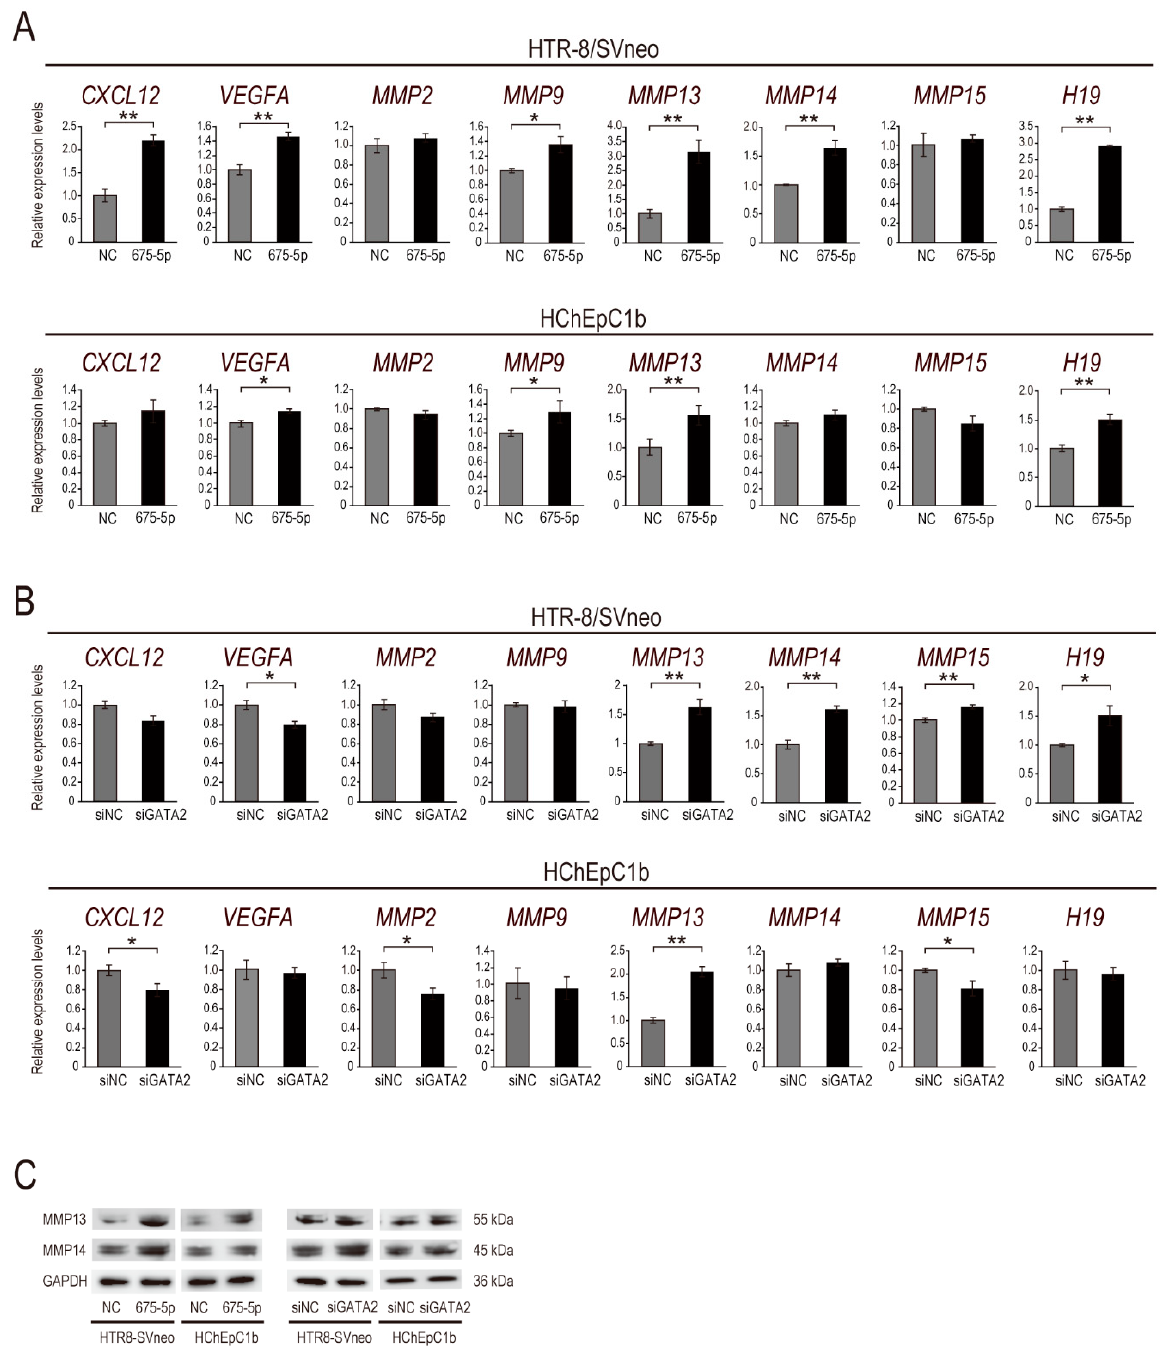
Figure 3. miR-675-5p -mediated GATA2 inhibition upregulated MMP13 and MMP14. ( A ) qPCR analysis of genes associated with cell invasion in EVT cell lines (HTR-8/SVneo and HChEpC1b) transfected with 50 nM miR-675-5p (675-5p) or negative control (NC) mimic and cultured for 48 h. ( B ) qPCR analysis of genes associated with cell invasion in EVT cell lines transfected with 20 nM siGATA2 or siNC and cultured for 24 h. ( C ) Western blot of MMP13 and MMP14. MMP13 and MMP14 expression in EVT cell lines transfected with 675-5p or a NC mimic (left panel); MMP13 and MMP14 expression in cells transfected with siGATA2 or siNC (right panel). Normalization in qPCR was performed using 18S; GAPDH was used as the internal control in Western blotting. Data are presented as the mean ± SD of the results of three independent experiments. * p < 0.05, ** p < 0.01; Student’s t -test.